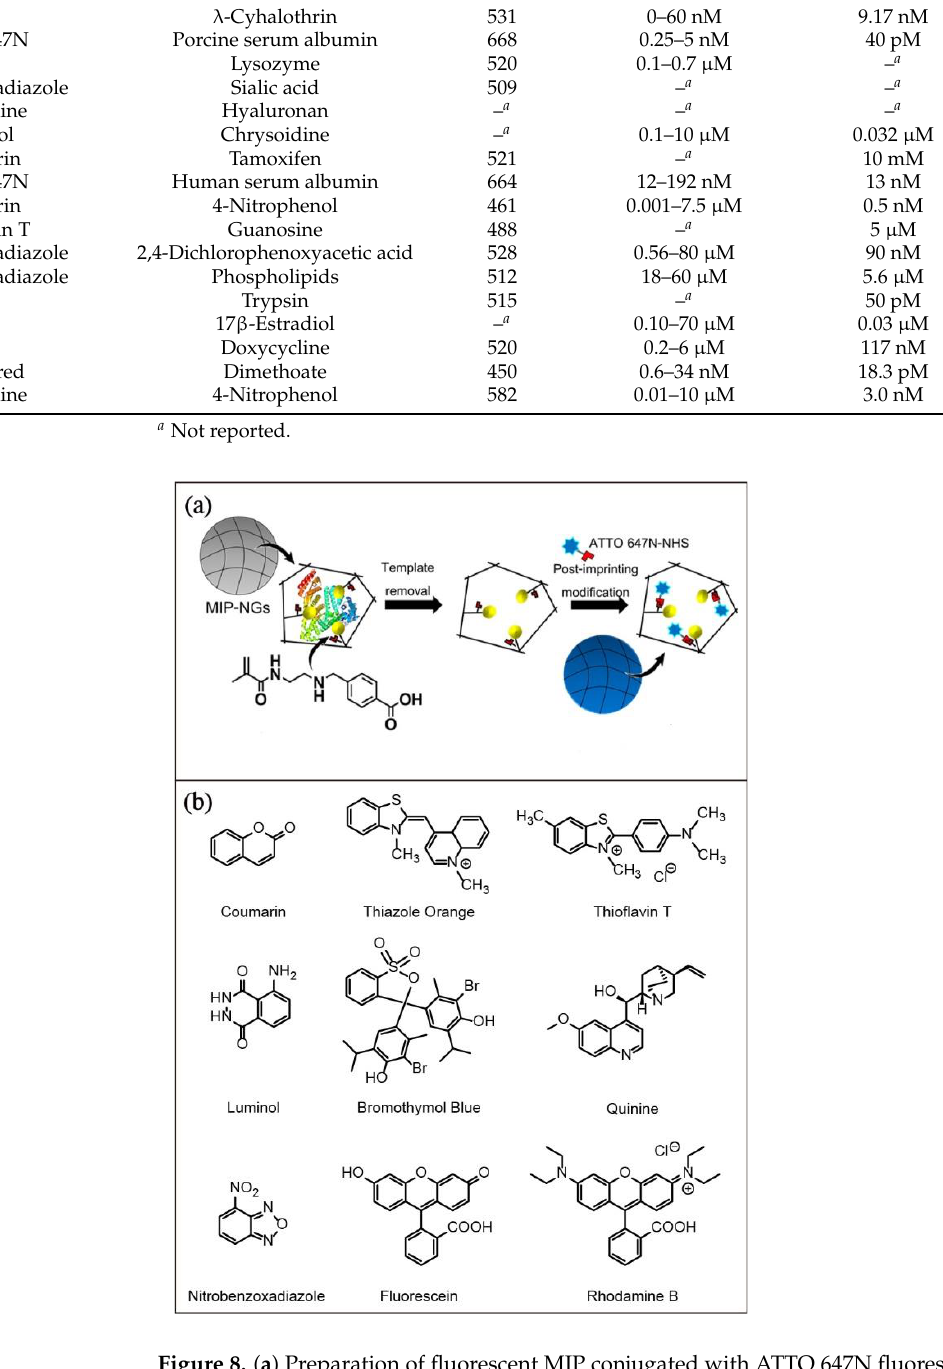
Table 3. Selected examples of organic fluorescent dye-functionalized luminescent MIP chemosensors. Fluorescent Dye